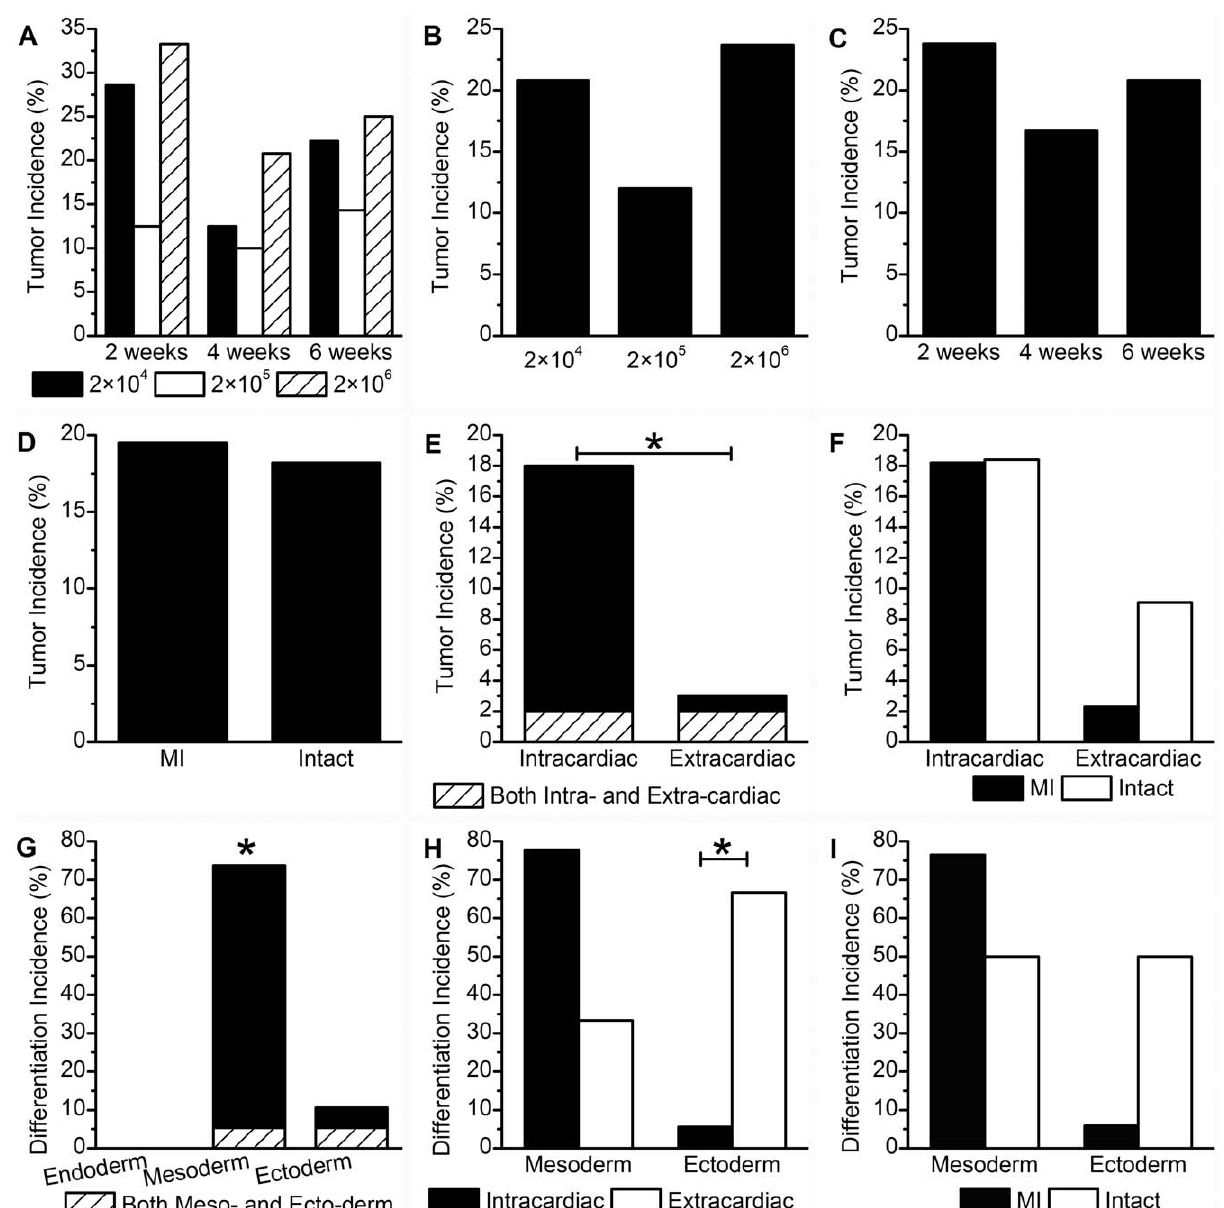
Figure 3. Tumor incidence in rats after transplantation of undifferentiated rat iPSCs and differentiation of the tumors. A - C, Tumor incidence in MI rats receiving different cell doses and/or subjected to various transplant durations. Cell dosage had no significant influence on tumor incidence, regardless of transplant duration (A and B) . Likewise, transplant duration had no significant influence on tumor incidence, regardless of cell dose (A and C) . D, There was no significant difference in tumor incidence between MI and intact rats. E, Intracardiac tumor incidence was significantly higher than that of extracardiac tissues ( P =0.001). F , Infarction had no significant influence on intracardiac/extracardiac tumor incidence. G , The incidence of mesodermal differentiation was significantly higher than endodermal or ectodermal differentiation of tumors ( P , 0.001). H, Intracardiac tumors had a lower incidence of ectodermal differentiation than extracardiac tumors ( P =0.041), but no significant difference in the incidence of mesodermal differentiation was found between intracardiac and extracardiac tumors. I, Infarction had no significant influence on tumor differentiation. doi:10.1371/journal.pone.0019012.g003 Some most recent studies have reported that the reprogram- along lineages related to donor cell identity [21-23]. For example, M13 iPSCs were induced from bone marrow cells, which may ming process and subsequent culture of iPSCs in vitro can induce explain the prevalence of chondro-osteogenic differentiation genetic and epigenetic abnormalities in these cells, regardless of observed in this study, in spite that M13 cells support the the reprograming methods, integrating or non-integrating [25-29]. Potential risks exist in all stages of the induction of iPSCs and their differentiation into cell types of all three germ layers after intramuscular injection into immunocompromised recipients [24]. subsequent expansion. So iPSCs generated by any method should